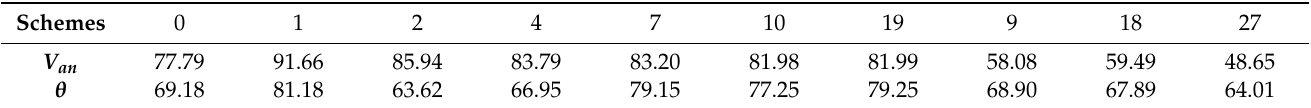
Table 2. Numerical analysis of inlet section under different schemes.